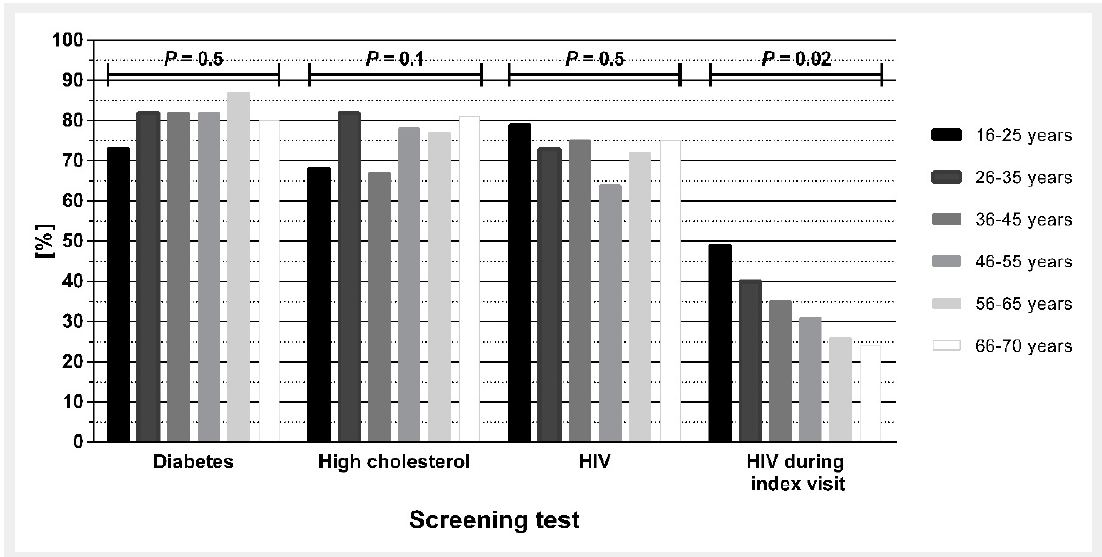
Figure 3 Profile of participating patients, by age, who agreed in principle to nontargeted screening in the emergency department (ED) for diabetes, high cholesterol and human immunodeficiency virus (HIV) and who agreed to be HIV tested during their current ED visit. The p-values are derived from the chi squared